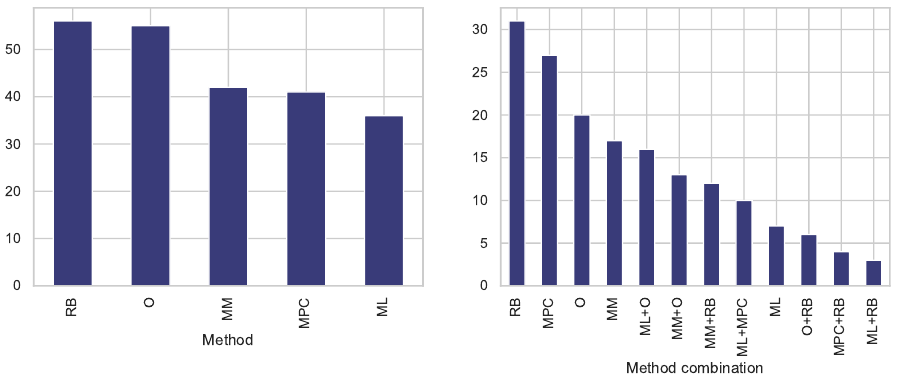
Figure 9. Methods used to determine control settings in the analyzed papers. ( Left ): occurrences of each method; ( right ): method